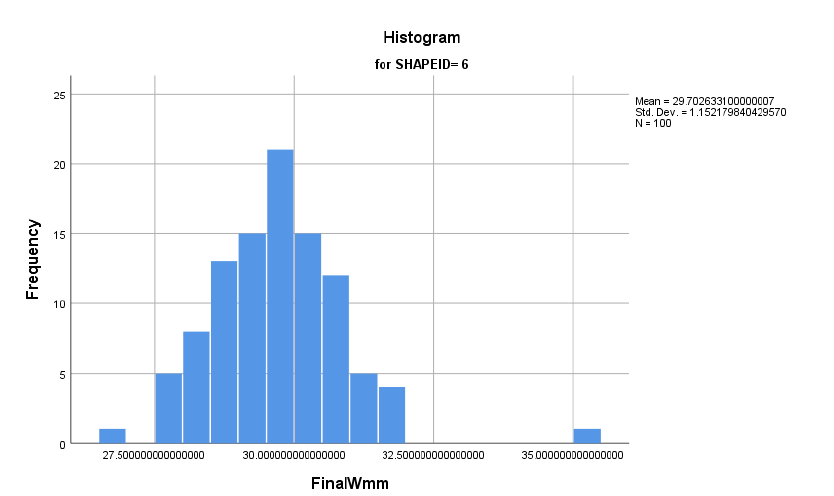
Figure A12. Grow width adjustment for 10 mm.